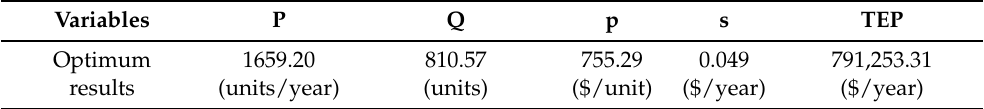
Figure 4. TEP as a function of ( A ) lot size quantity and average selling price and ( B ) average selling price and service-related variable. Table 3. Optimum results from Example